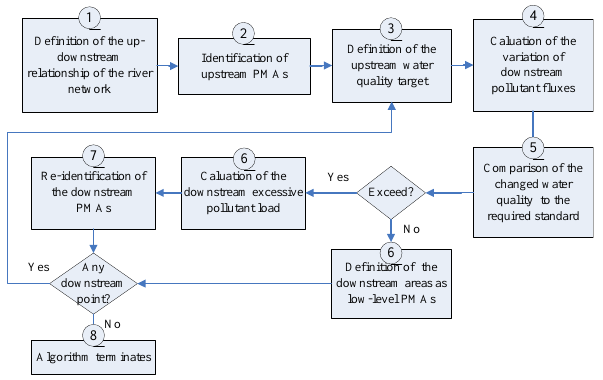
Fig. 1. The framework of the